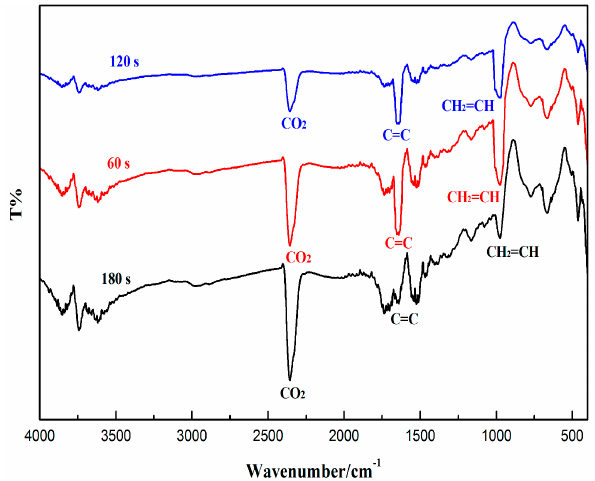
Figure 3. FT-IR spectra of PBF/PPF-DA showing the decrease in intensity of absorption bands at 1646 cm − 1 and 974 cm − 1 as a function of irradiation time.